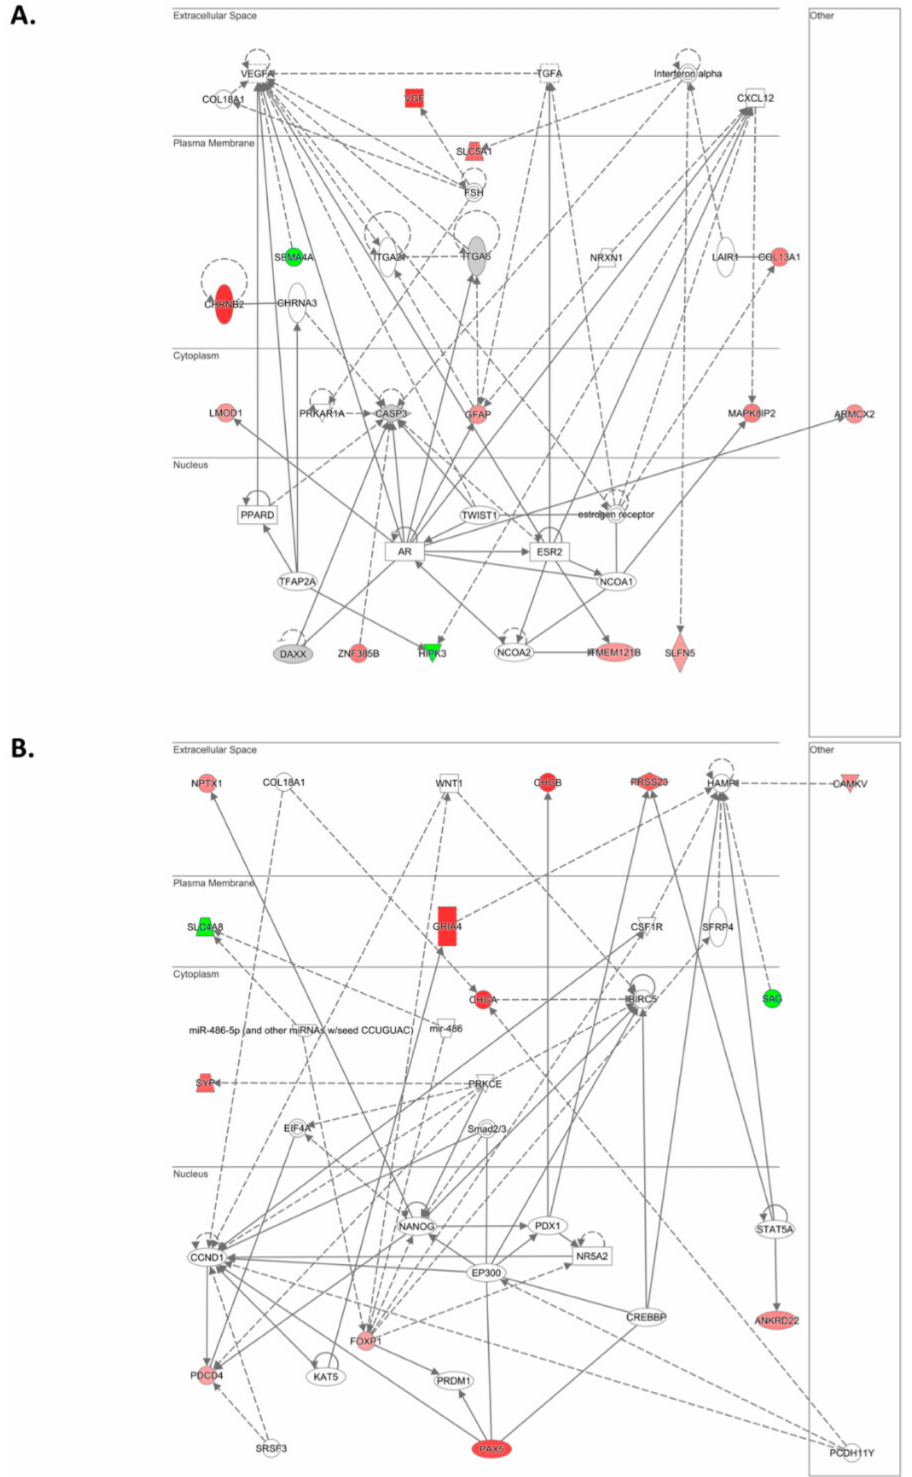
Figure 4. Network analysis by Ingenuity Pathway Analysis (IPA). The top two altered networks following siRNA-mediated ILK targeting are shown. ( A ) The top network includes molecules associated with nervous system development and function, organ morphology, and organismal development. ( B ) The second top network includes molecules associated with cell death and survival, cancer, and immunological disease. Green and red symbols denote downregulated and upregulated genes,